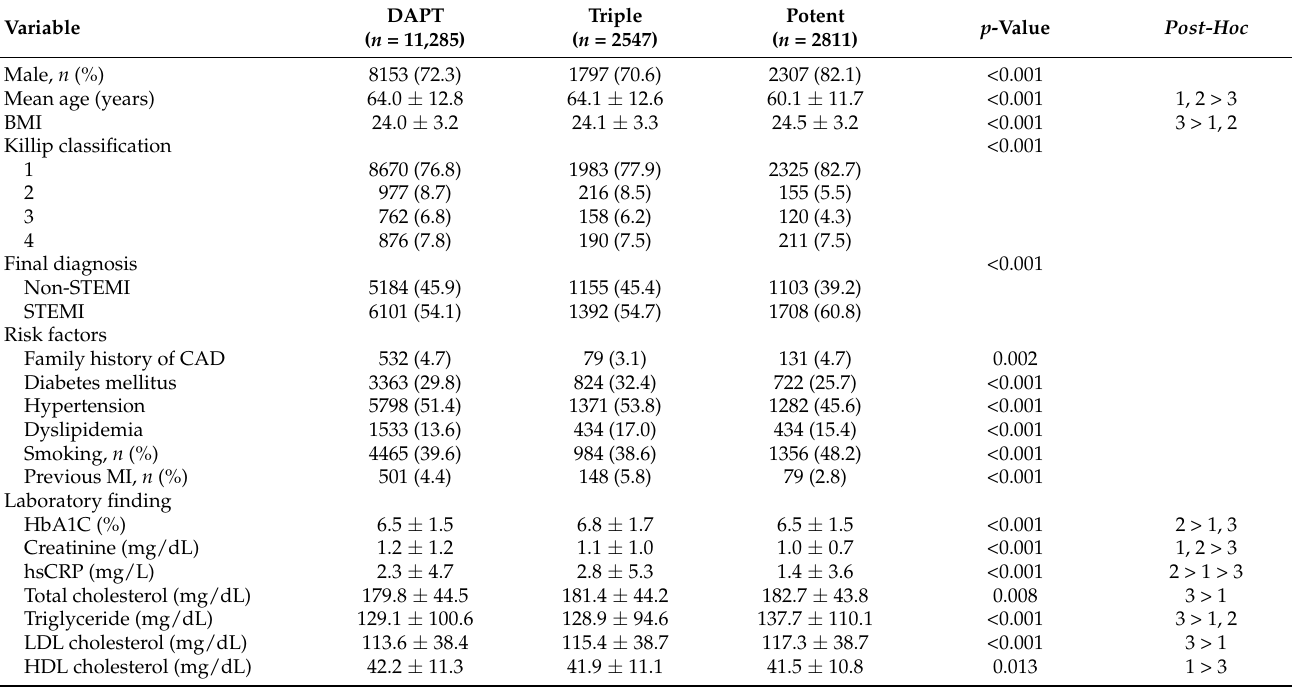
Table 1. Baseline